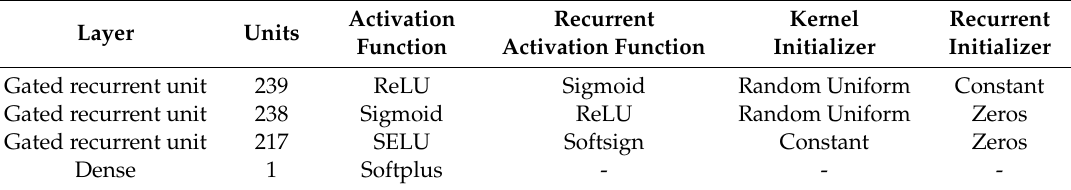
Table 5. Hyperparameters for deep learning model.